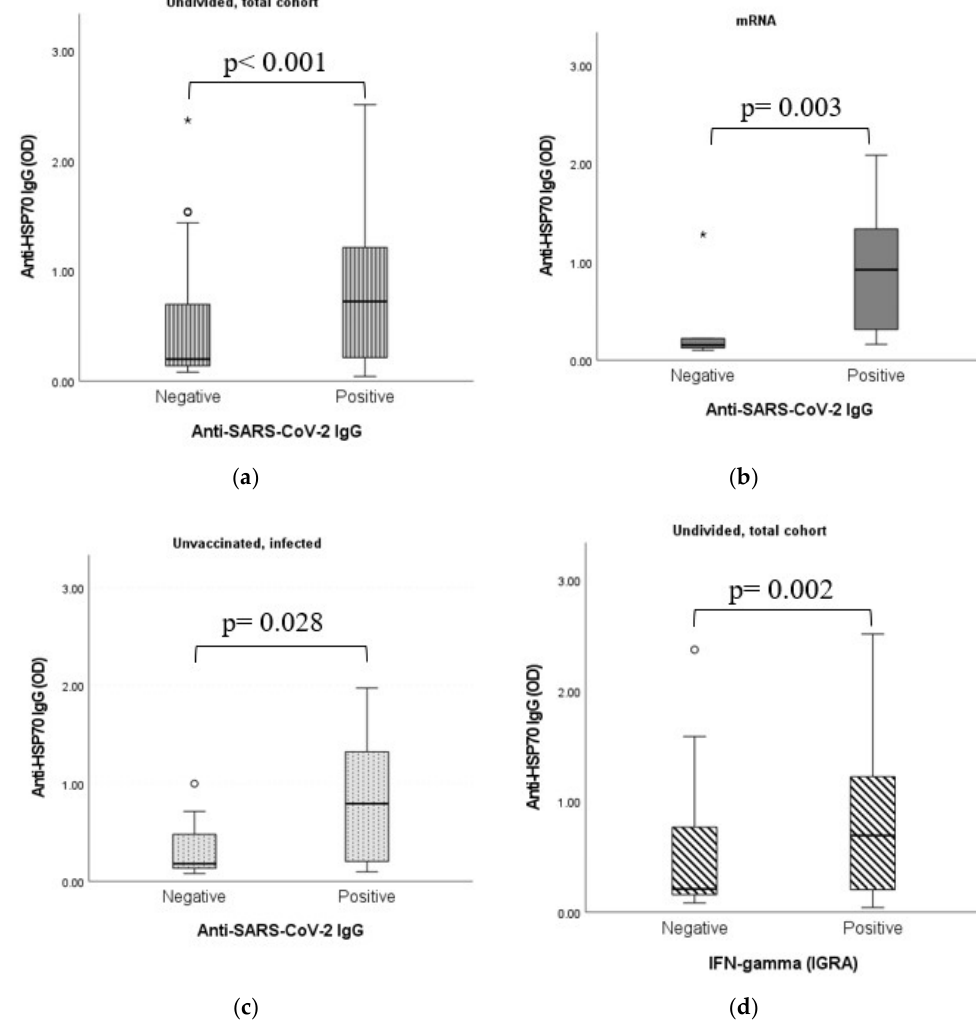
Figure 7. ( a ) Connection between anti-HSP70 IgG titers and anti-SARS-CoV-2 IgG results in the undivided, total sample cohort. ( b ) Connection between anti-HSP70 IgG titers and anti-SARS-CoV-2 IgG results in the mRNA vaccine group. ( c ) Connection between anti-HSP70 IgG titers and anti-SARS-CoV-2 IgG results in the unvaccinated, infected group. ( d ) Connection between anti-HSP70 IgG titers and IFN- γ (IGRA) results in the undivided, total sample cohort. Anti-SARS-CoV-2 IgG, IgA and IFN- γ (IGRA) qualitative (positive and negative) results were evaluated as per the manufacturer’s instructions. Anti-HSP70 IgG absorbance (OD) results were handled as continuous, non-normally distributed integers and the alterations of titers were considered. The sample numbers were as follows: ( a ) anti-SARS-CoV-2 IgG negative/positive = 48/136, ( b ) anti-SARS-CoV-2 IgG negative/positive = 12/15, ( c ) anti-SARS-CoV-2 IgG negative/positive = 12/15 and ( d ) IFN- γ (IGRA) negative/positive = 43/142. Total =